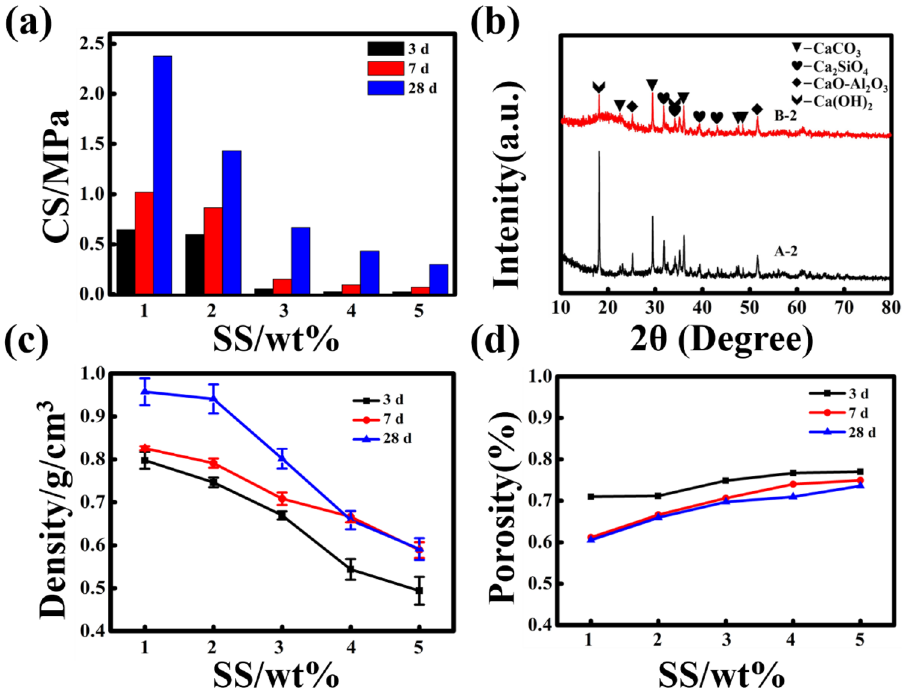
Figure 3. Properties of expansive materials with different doses of sodium silicate. ( a ) compressive strength, ( b ) XRD pattern of group A-2 and B-2 samples after cured for 7 d, ( c ) density, ( d )